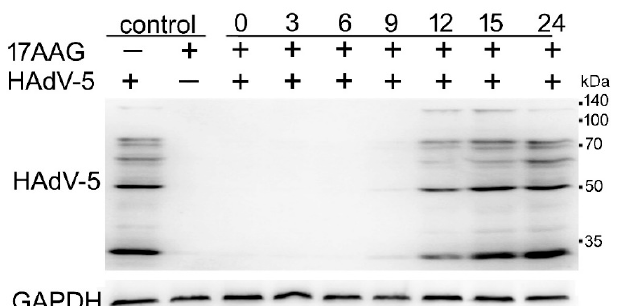
Figure 4. 17-AAG inhibits translation of HAdV-5 proteins 9 h after infection. A549 cells were infected with HAdV-5. 17-AAG was added to a final 0.25 μ M concentration at the indicated times and culture was continued to a total of 24 h. Expression of virus proteins was detected with anti-HAdV-5 polyclonal antibody.